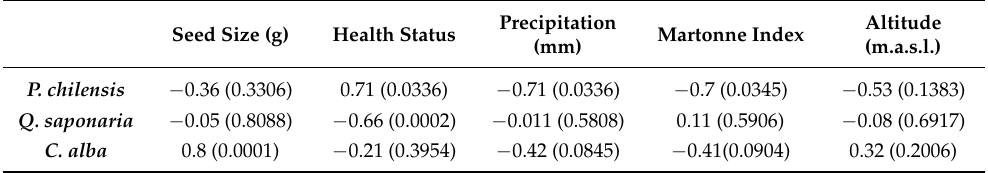
Table 3. Pearson coefficient of correlation for germination capacity (%) and seed size (g), health status, and climatic (precipitation (mm) and Martonne) and geographical (altitude (m.a.s.l.)) traits. p -values in